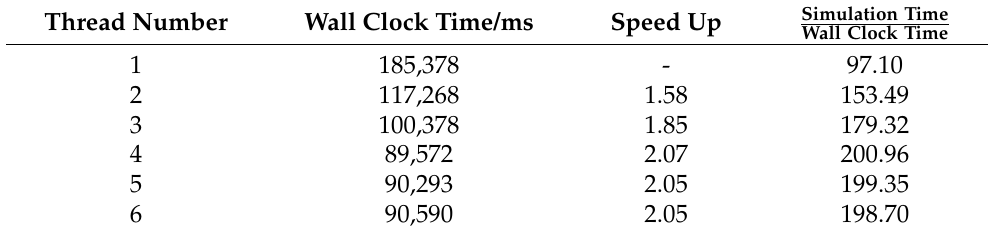
Table 2. The performance results of multithreading